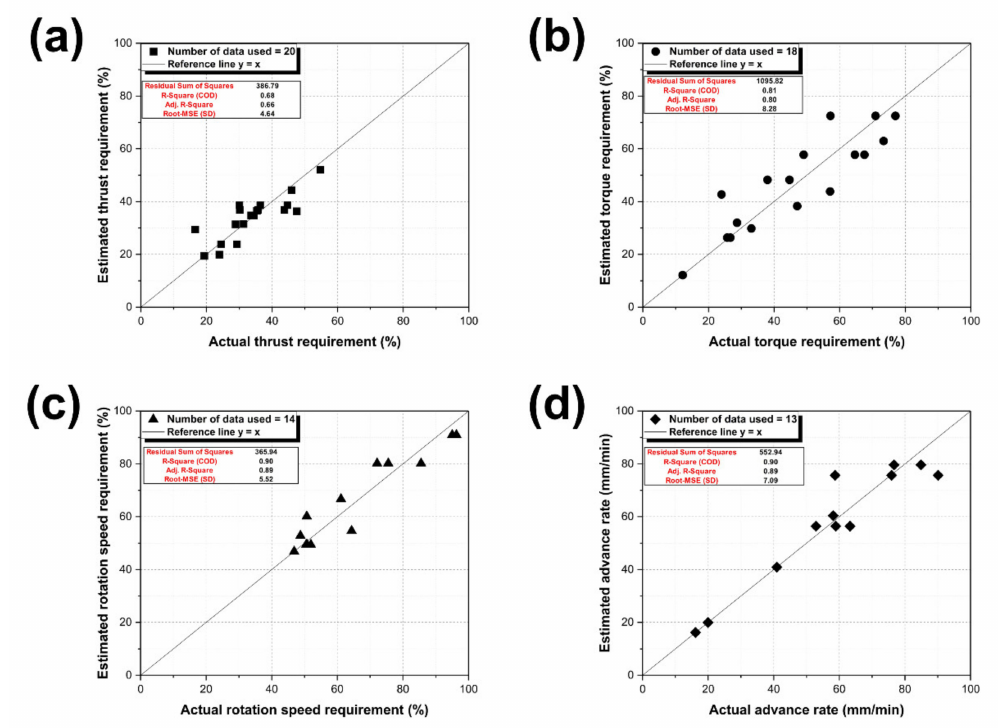
Figure 2. Results of multiple regression analysis for soil excavation. Estimations of required ( a ) thrust, ( b ) cutterhead torque, ( c ) rotation speed, and ( d ) advance rate.